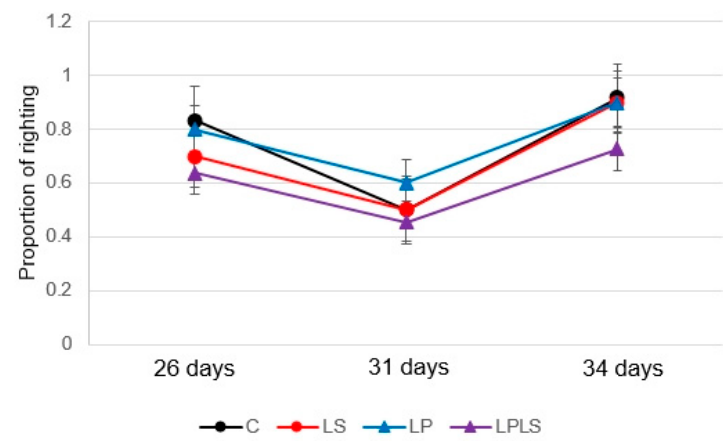
Figure 3. Proportion of righting for each group with exposed days (Mean ± SE). The control pH and salinity, low salinity, low pH, and low salinity and pH groups are represented by black, red, blue, and purple, respectively, and N = 12, 10, 10, and 11, respectively.